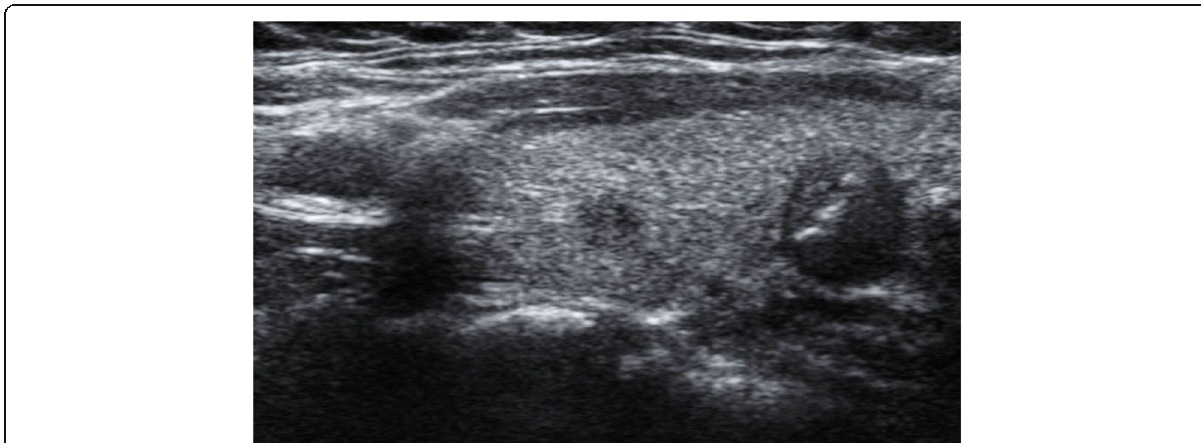
Fig. 1 The ultrasound-guided fine-needle aspiration from a hypoechoic nodule with regular margin and less than 5 punctate echogenic foci in the left thyroid lobe of a 26-year-old female patient, which was proved by cytology to be a nodular goiter